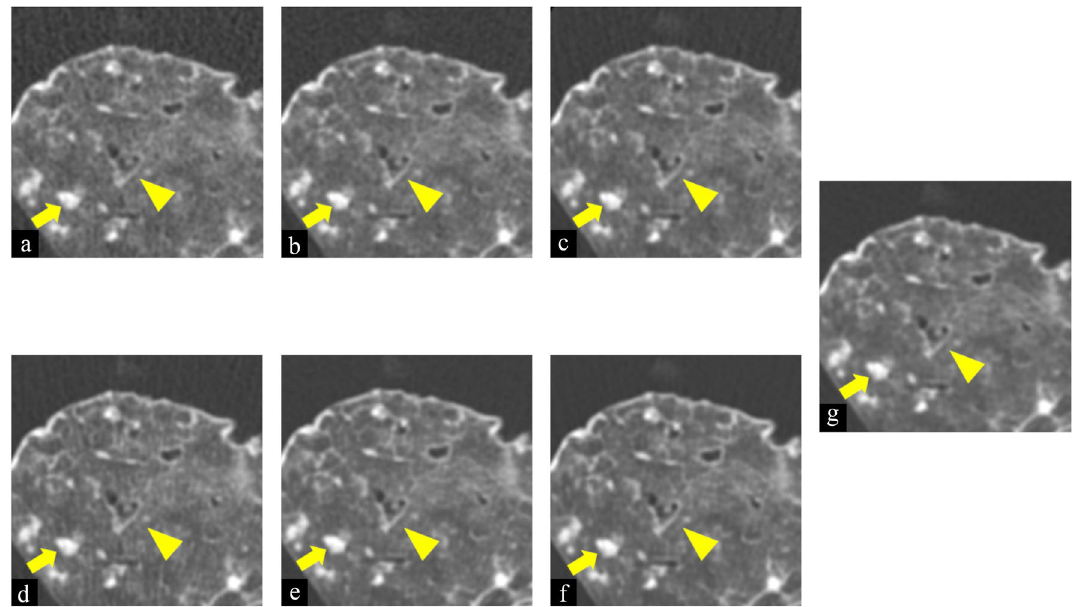
Figure 3. Images of filtered back projection (FBP) at 10 ( a ), 25 ( b ), 50 ( c ), and 175 mAs ( g ) and True Fidelity Image (TFI) at 10 ( d ), 25 ( e ), and 50 mAs ( f ) of cadaveric lung (usual intestinal pneumonia). Window width was 1200 and Window level was − 700 (Hounsfield Unit). Scan field of view was 20 cm. The length and width of each figure was 6.5 cm. As tube current–time product decreased, the shape of the nodule (arrowhead) and bronchiectasis (arrow) at TFI and FBP varied slightly or were almost the same as that of 175 mAs-FBP.